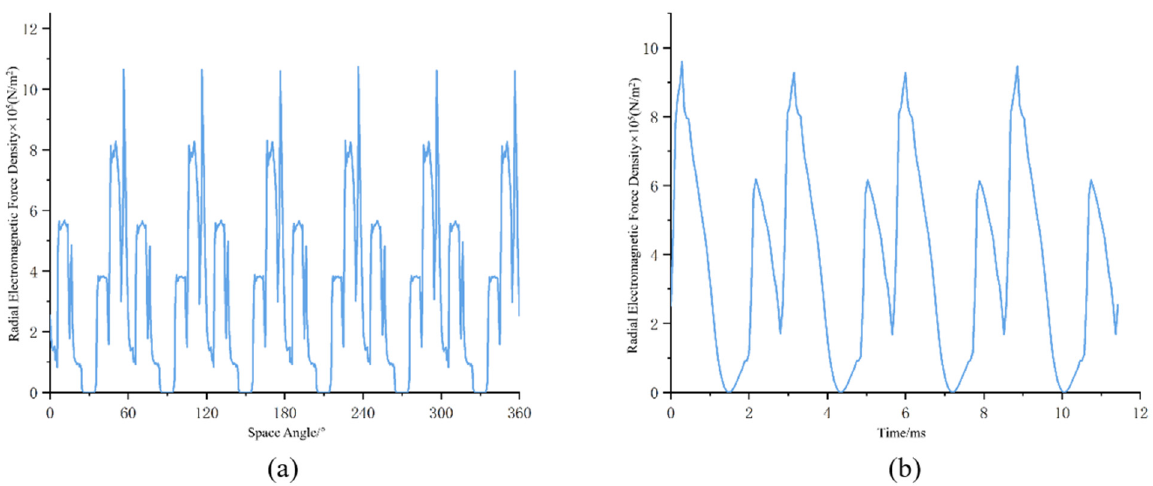
Figure 3. Radial electromagnetic force variation: ( a ) 0.01 s changes with space angle; ( b ) change in time at a point on the stator tooth end.